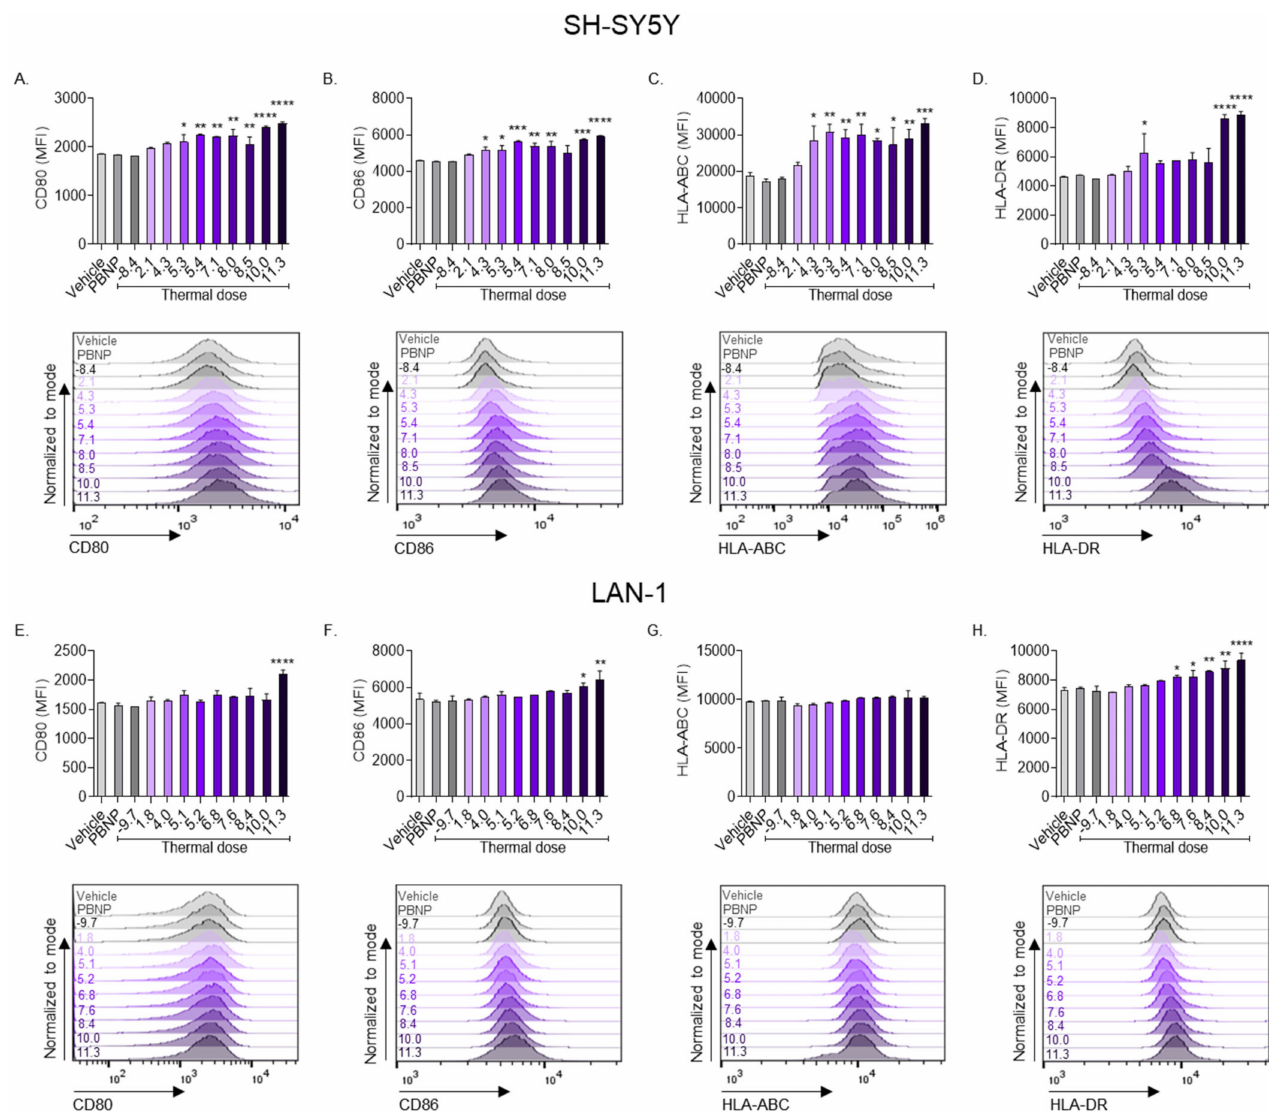
Figure 4. The effect of PBNP-PTT-administered thermal dose on co-stimulatory and HLA molecules is more pronounced in SH-SY5Y cells compared with LAN-1 cells. ( A – D ) SH-SY5Y and ( E – H ) LAN-1 cells were subjected to various thermal doses via PBNP-PTT. After treatment, cells were rested for 24 h and evaluated by flow cytometry analysis for ( A , E ) CD80, ( B , F ) CD86, ( C , G ) HLA-ABC, and ( D , H ) HLA-DR. MFI is represented as bar graphs representing averages, and corresponding representative histograms. Inset values in the histograms denote the thermal dose. Each parameter was compared to the vehicle control by one-way ANOVA, where * p < 0.03, ** p < 0.002, *** p < 0.0002, **** p < 0.0001; n =